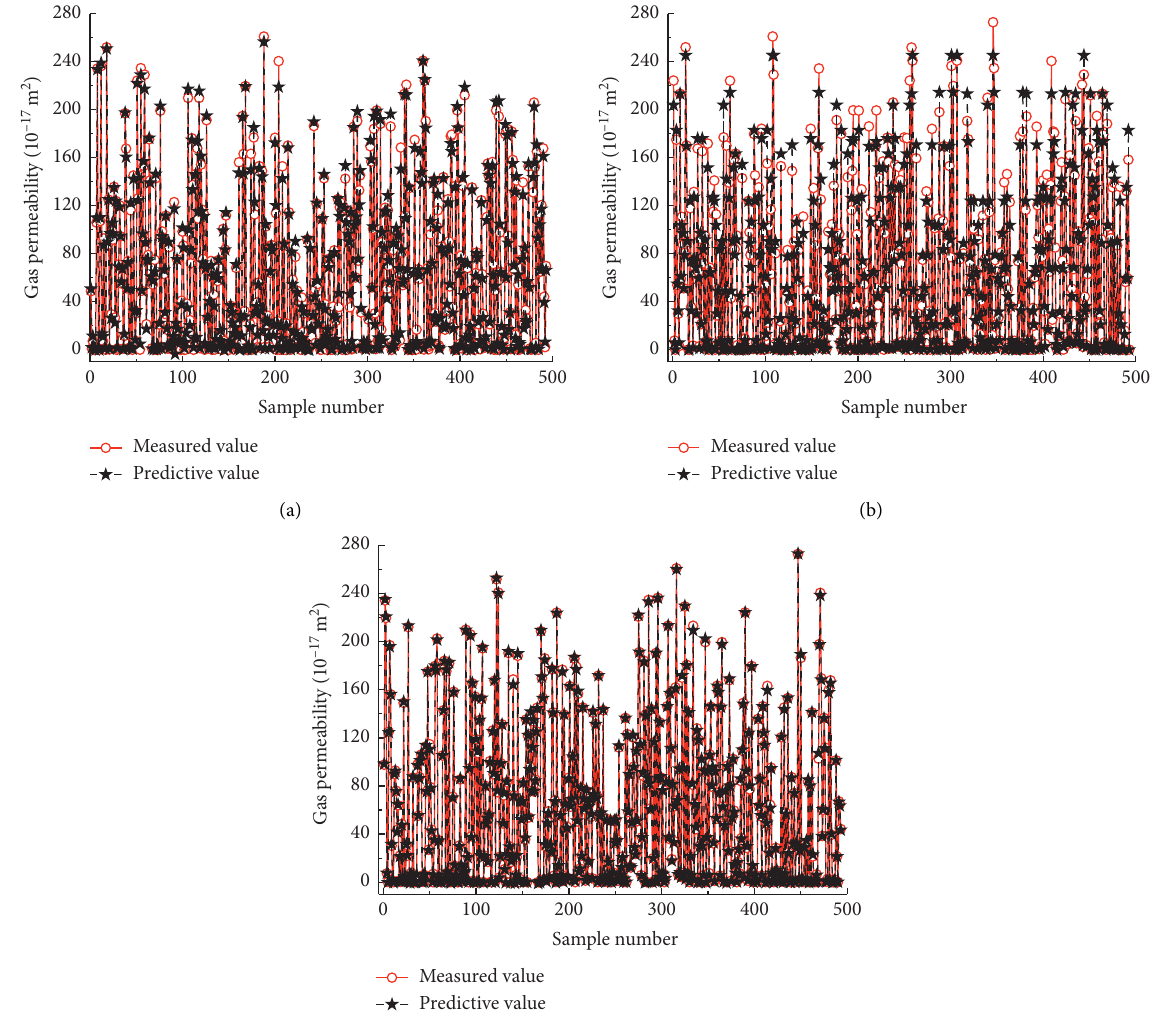
Figure 6: Predictive performance of the models for the training dataset. (a) MEA-SVM. (b) GA-SVM. (c)